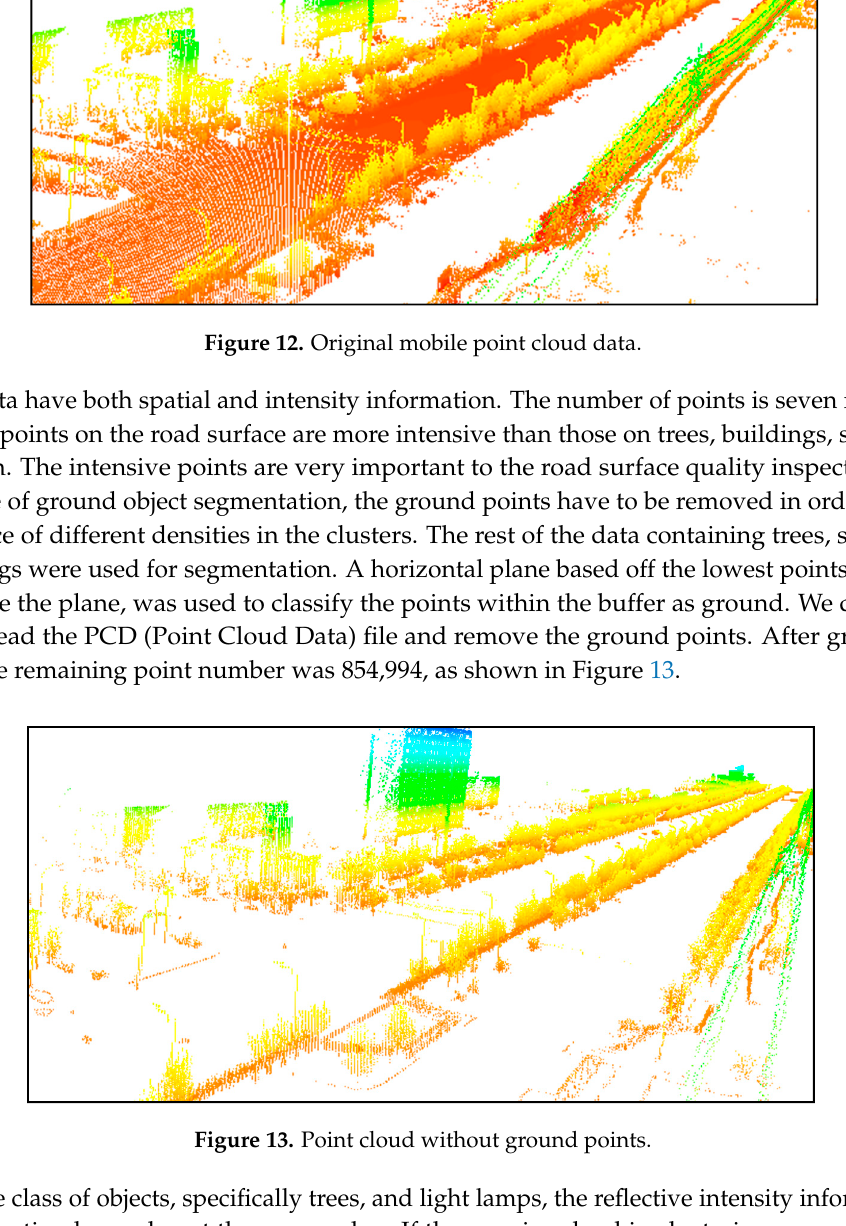
Figure 14. Part of the reference data.